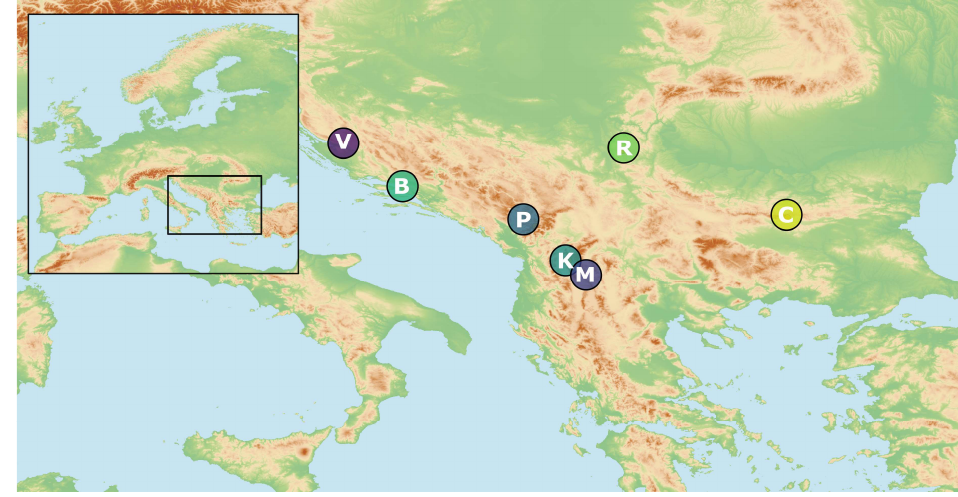
Figure 2. Spatial distribution of analysed populations of Juniperus sabina var. balkanensis; for popu- lation details, cf. Table 1.